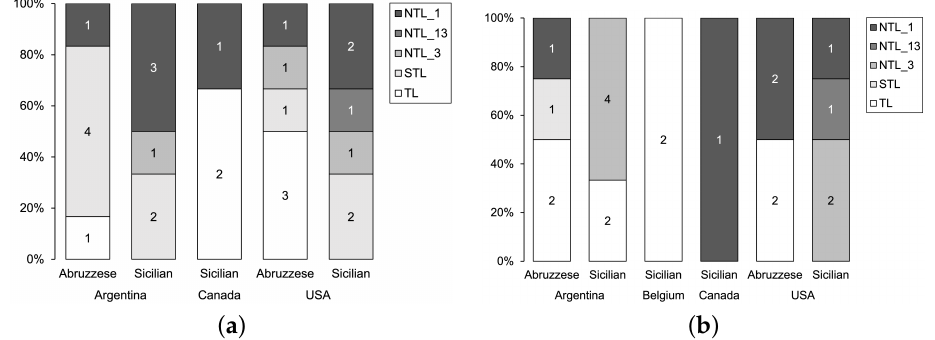
Figure 6. Hearer-related deictic domain across different heritage varieties in contact with one and the same dominant language: results for picture sentence matching task ( a ) and semi-guided production ( b